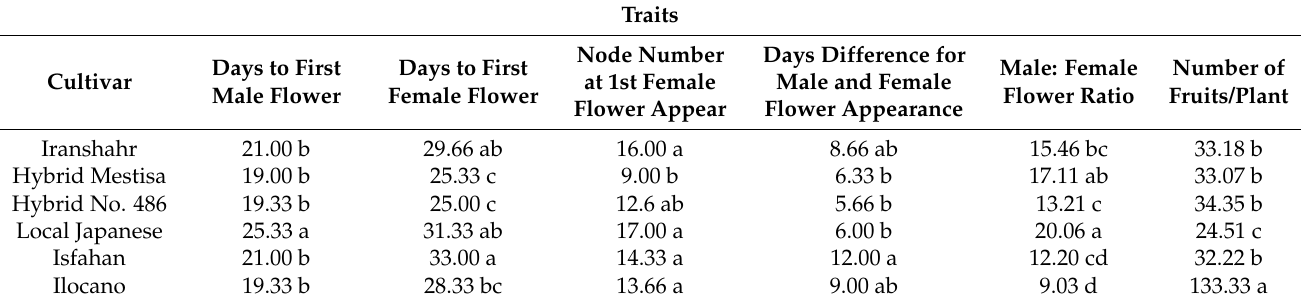
Table 2. Mean comparison of reproductive characteristics of six bitter melon cultivars.